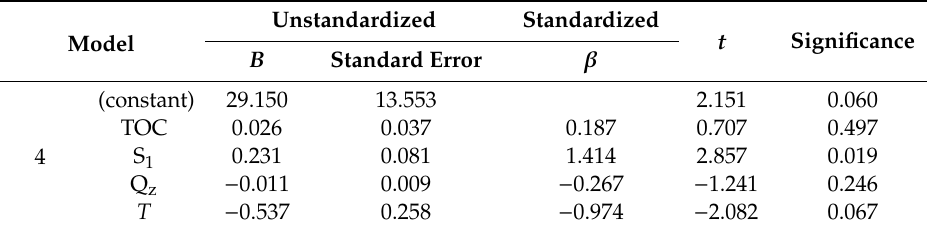
Table 5. Coe ffi cient a . Table 5. Coefficient a .